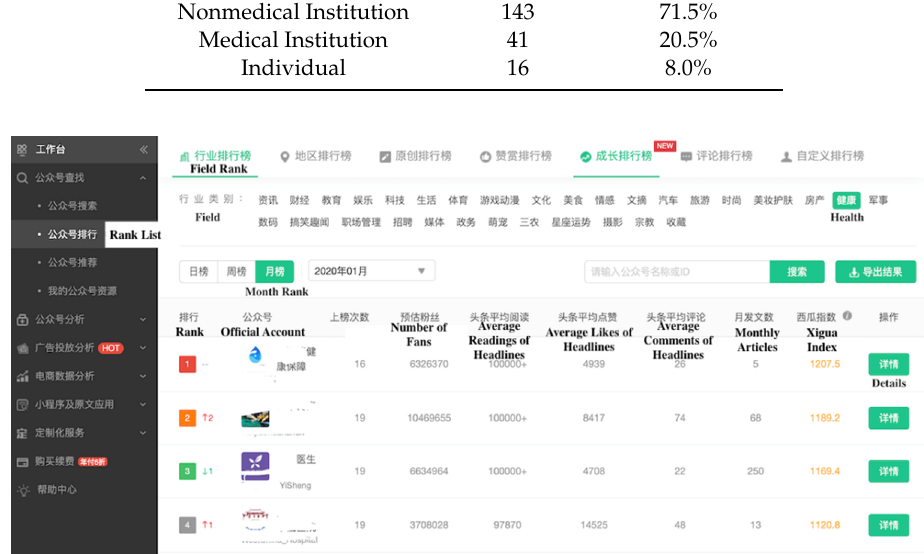
Figure 2. Screenshot of the rank list page. Some important nouns and items were translated into English. From: